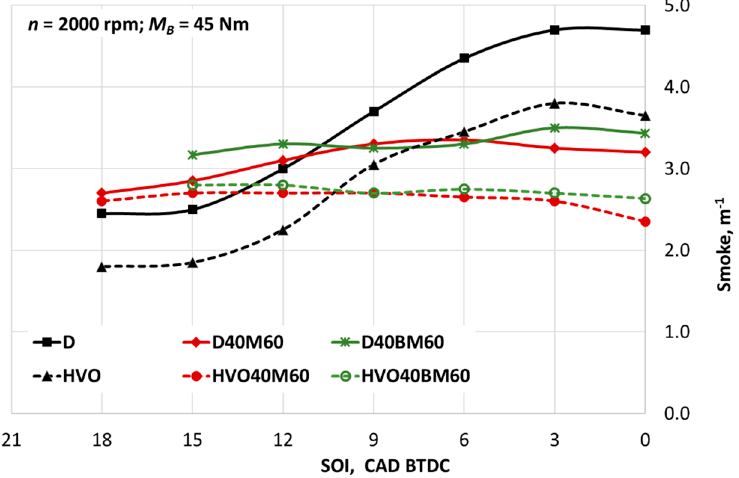
Figure 9. Change of smoke depending on fuel composition and SOI.